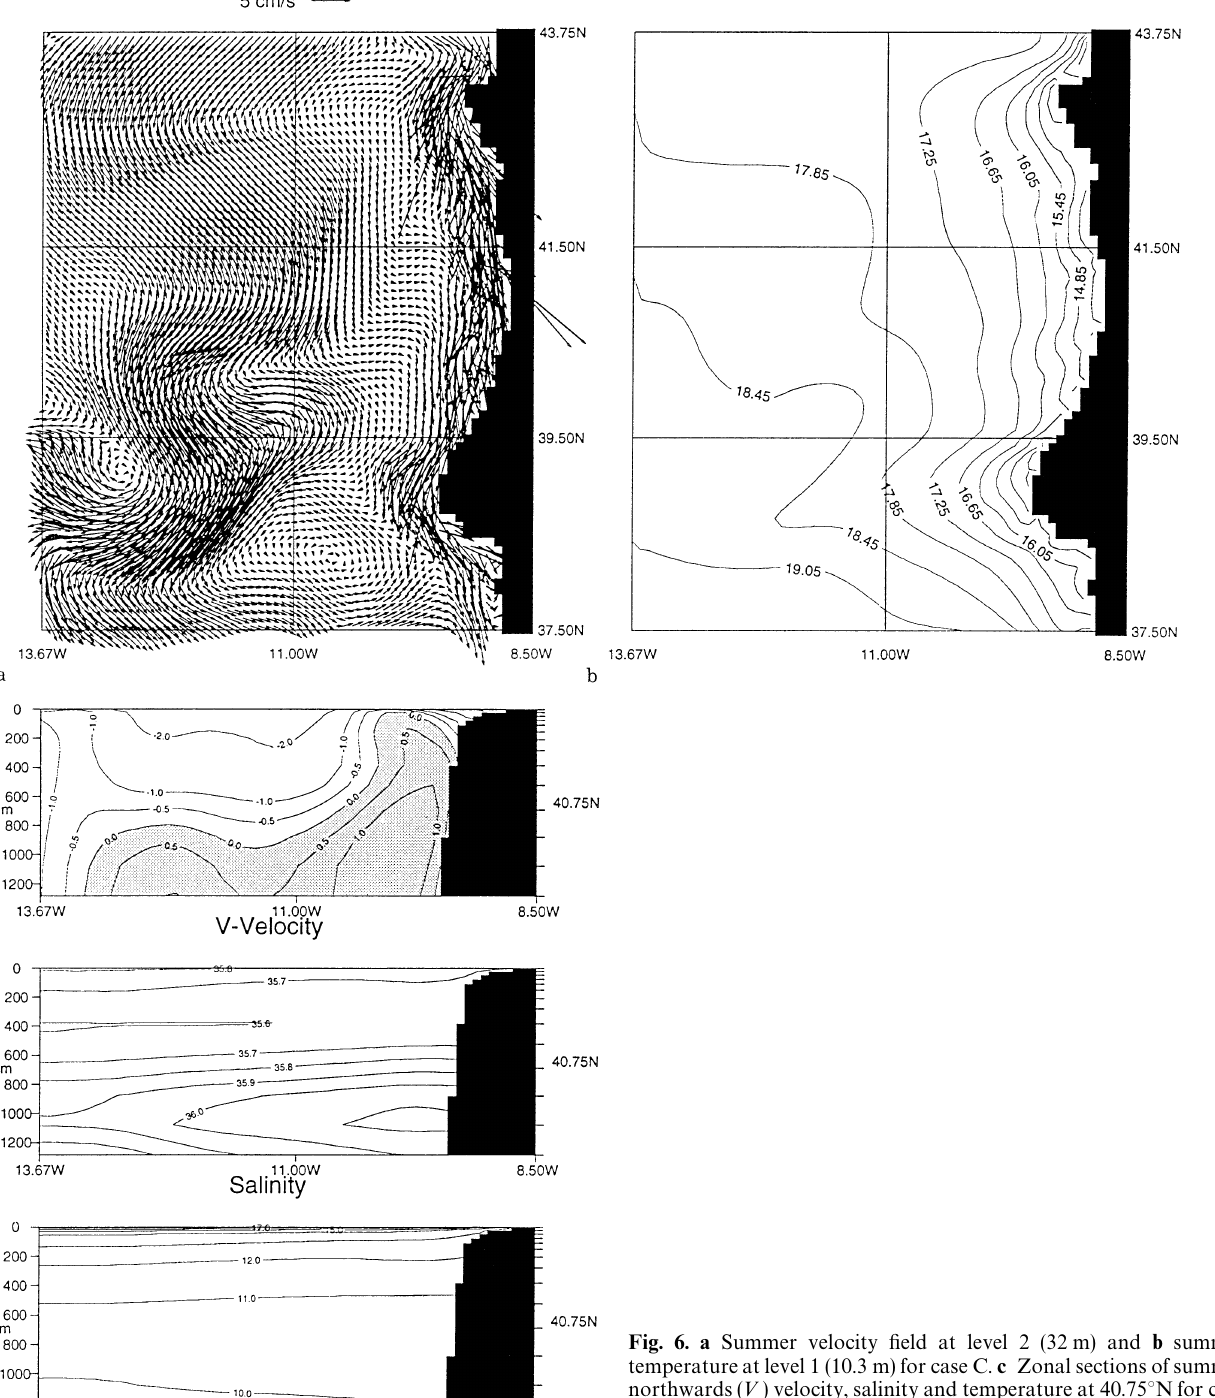
Fig. 6. a Summer velocity field at level 2 (32 m) and b summer temperature at level 1 (10.3 m) for case C. c Zonal sections of summer northwards ( » ) velocity, salinity and temperature at 40.75 ° N for case C. Northwards velocities in cms (cid:126)(cid:49) are shaded